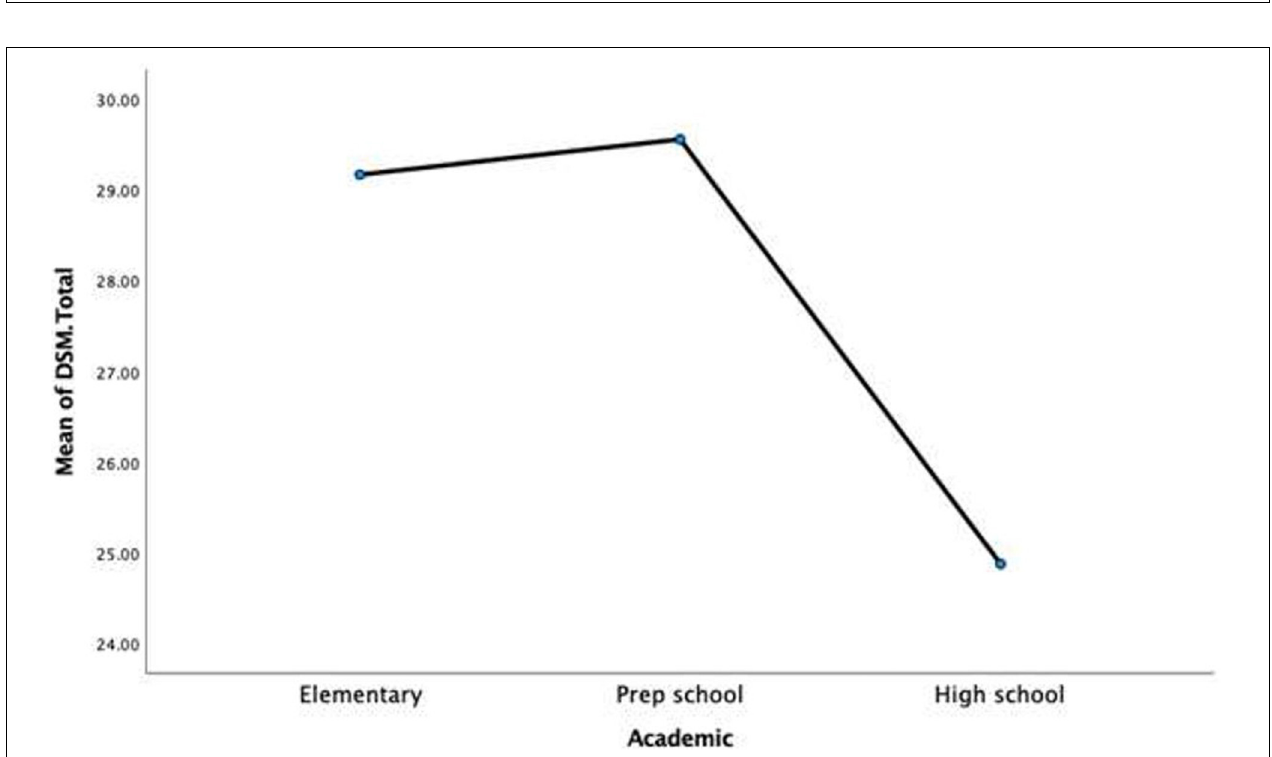
FIGURE 4 | Mean internet gaming disorder short scale (IGDSS) scores on elementary, prep school, and high school grades.